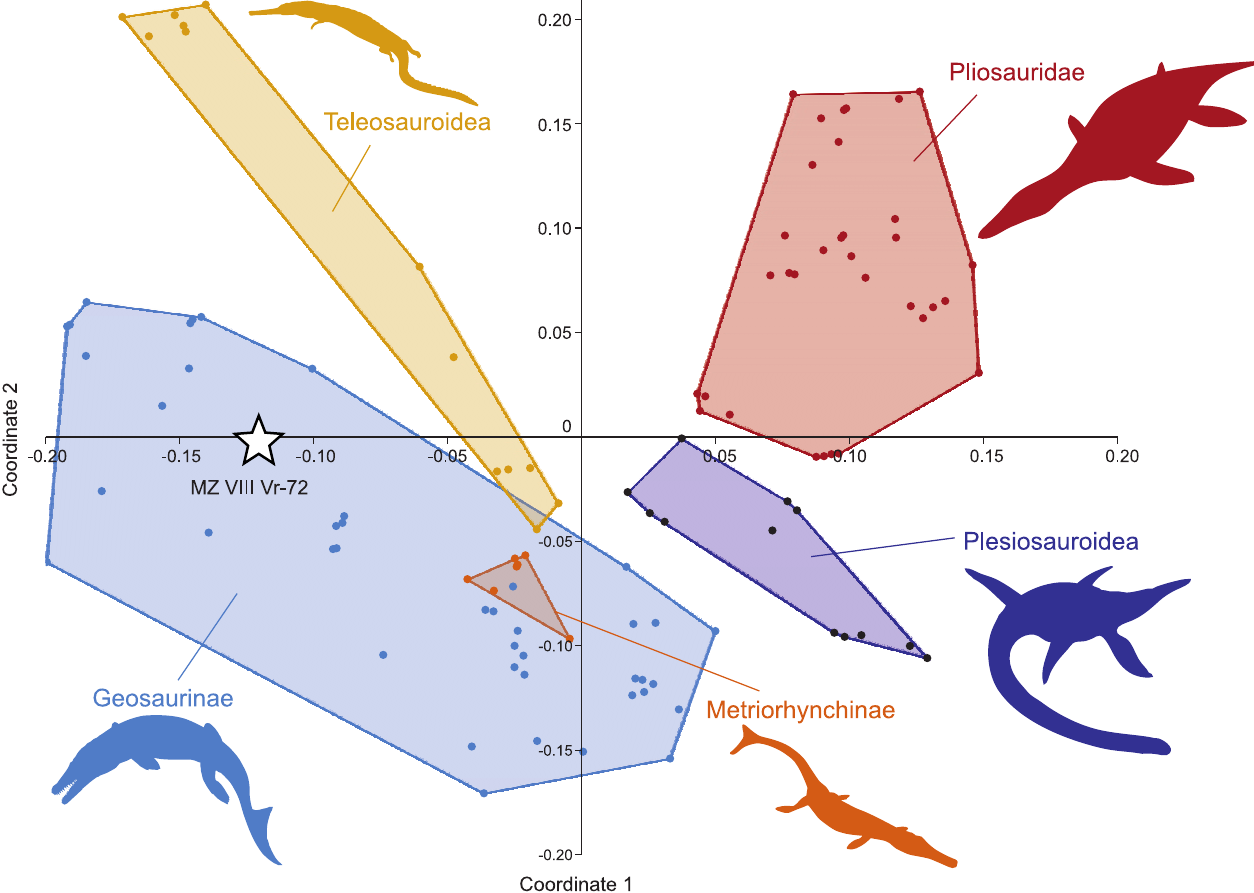
Fig. 11. Morphospace occupation of MZ VIII Vr-72 (white star) among Jurassic marine reptiles (thalattosuchians and plesiosaurs), resulting from principal coordinates analysis of the dataset of Foffa et al. (2018c), segregated along principal coordinates 1 and 2. See SOM 3 for extended results of the principal coordinates analysis. Silhouettes obtained from phylopic.org: Geosaurinae (Dmitry Bogdanov, CC BY 3.0), Metriorhynchinae and Teleosauroidea (Gareth Monger, CC BY 3.0), Plesiosauroidea (Adam Stuart Smith, CC BY-SA 3.0), and Pliosauridae (Nobu Tamura, CC BY-SA